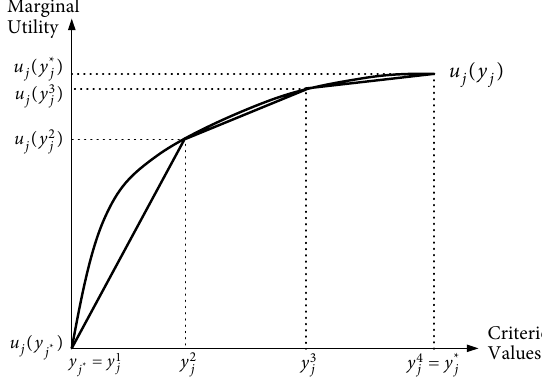
Fig. 1. Piecewise linear approximation of marginal utilities for 4